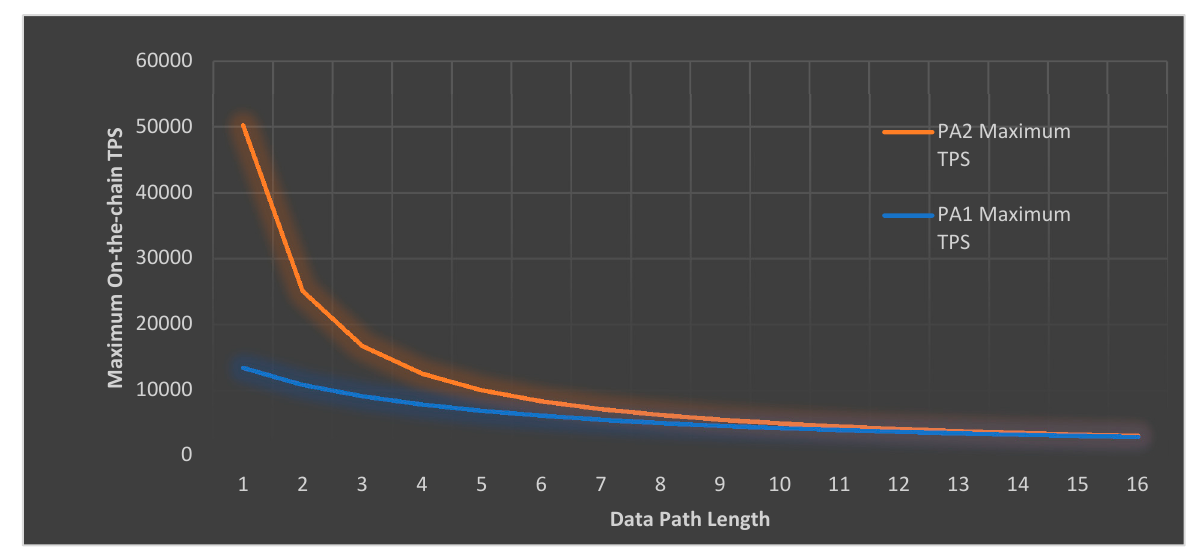
Figure 18. The effect of path length on the achievable TPS in a ‘strict’ case. Each compartment on the x-axis represents the achievable Transactions Per Second (TPS) statistic achievable at a particular path length. If the user is in possession of a Token Pool with multiple dimensions (Multi-Dimensional Token Pools), they wouldn’t need to initiate payout clearance each time a new data path was to be formed, as they would simply pick a new dimension from the Token Pool to incentivize the newly formed data-path and continue from a previous one once and if the previous data path turns out viable again. The number of simultaneous connections supported by PA 3 (taking use of both PA 1 for path establishments and PA 2 for actual data exchange) in the ‘realistic’ case is visible below [Figure 19].